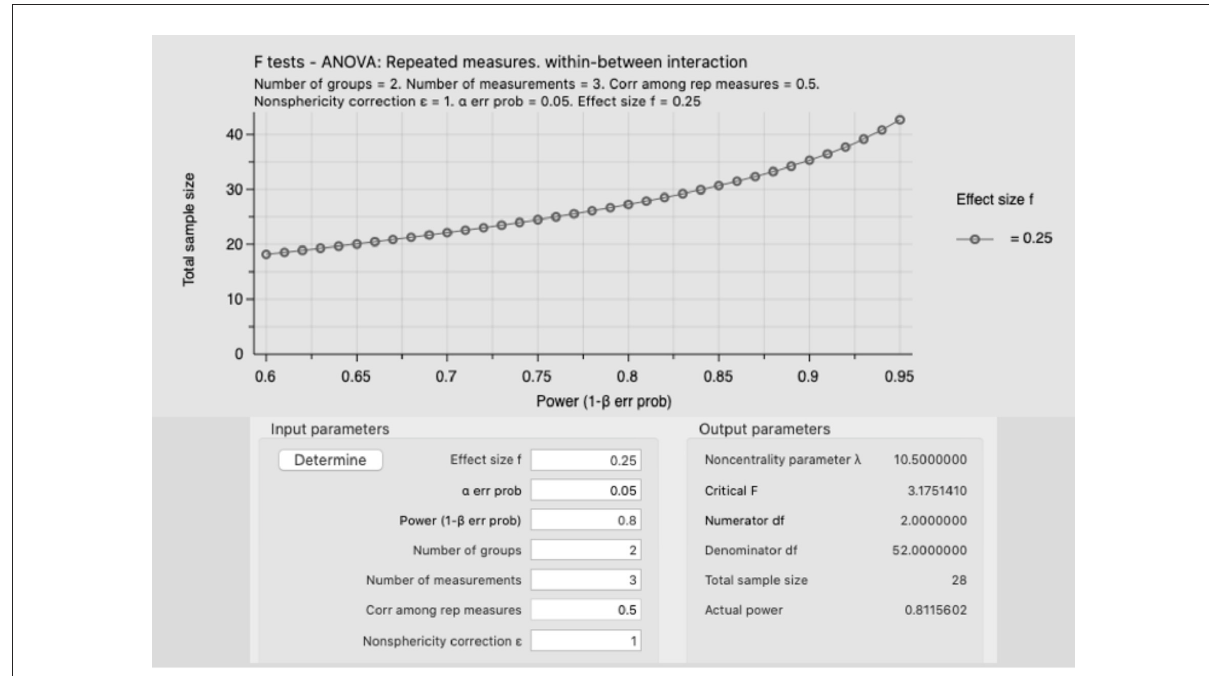
FIGURE1 Example of an a priori power analysis using an ANOVA, repeated measures, within-between interaction with a medium effect size (f = 0.25) and an alpha error prob of 0.05 (5%). The total sample size for this study is 28 participants, with an actual power of 0.811. Moreover, this figure shows that increasing the sample size (y axis) is possible to increase the power (1-beta err prob), for instance, recruiting 35 participants would increase the sample power to 0.9, which would decrease the type II